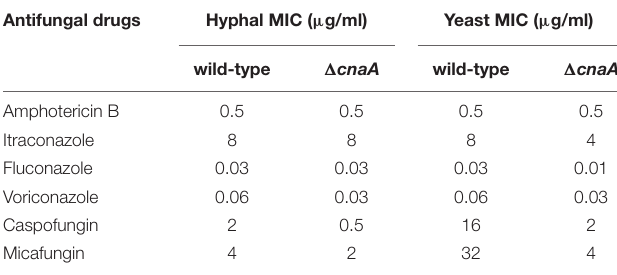
the (cid:49) cnaA strain were also readily phagocytosed by RAW264.7 TABLE 2 | In vitro assay of antifungal